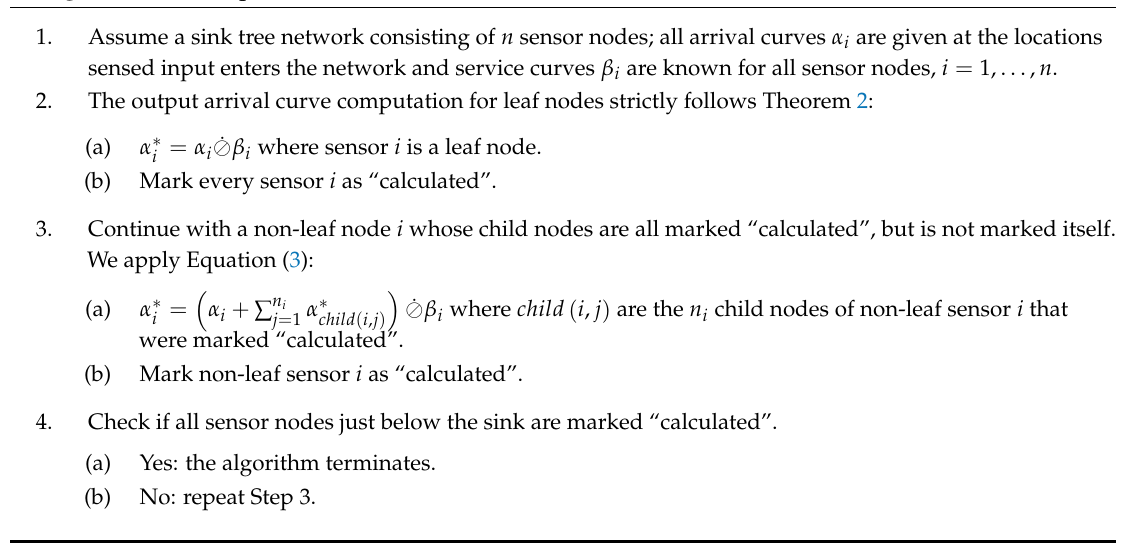
Algorithm 1: Computation of network-internal